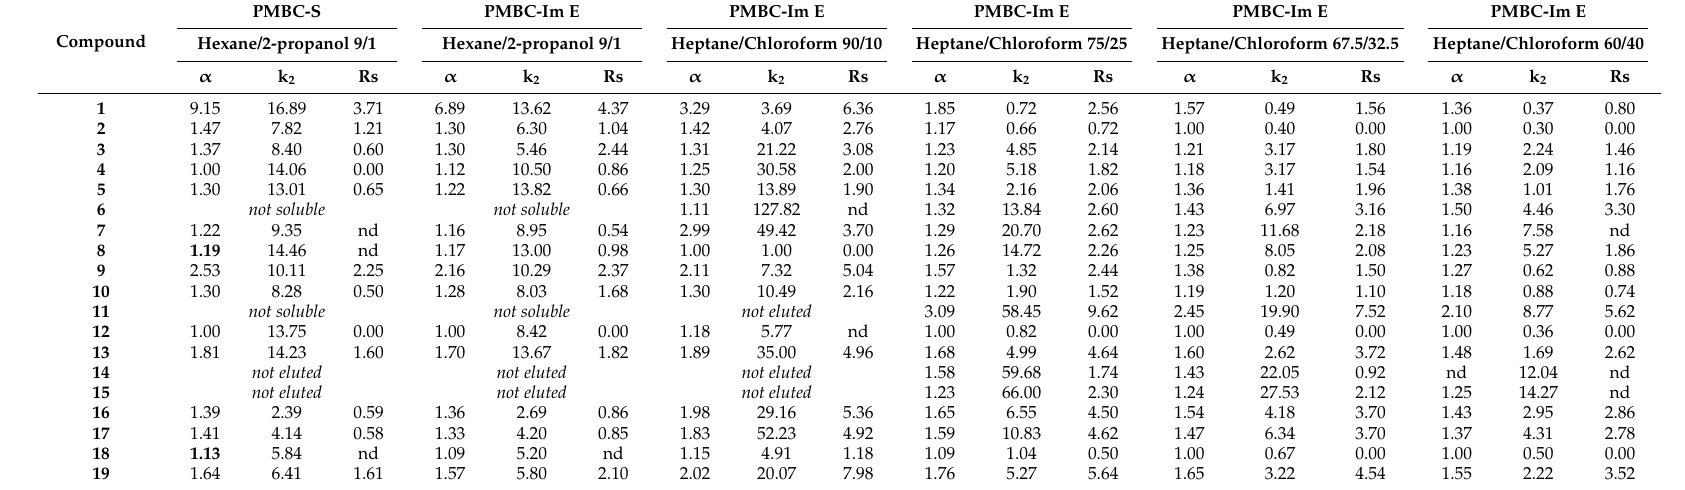
Table 4. Chromatographic results of the enantioselective separations of racemates 1 – 19 on photochemically immobilized PMBC-Im E: influence of mobile